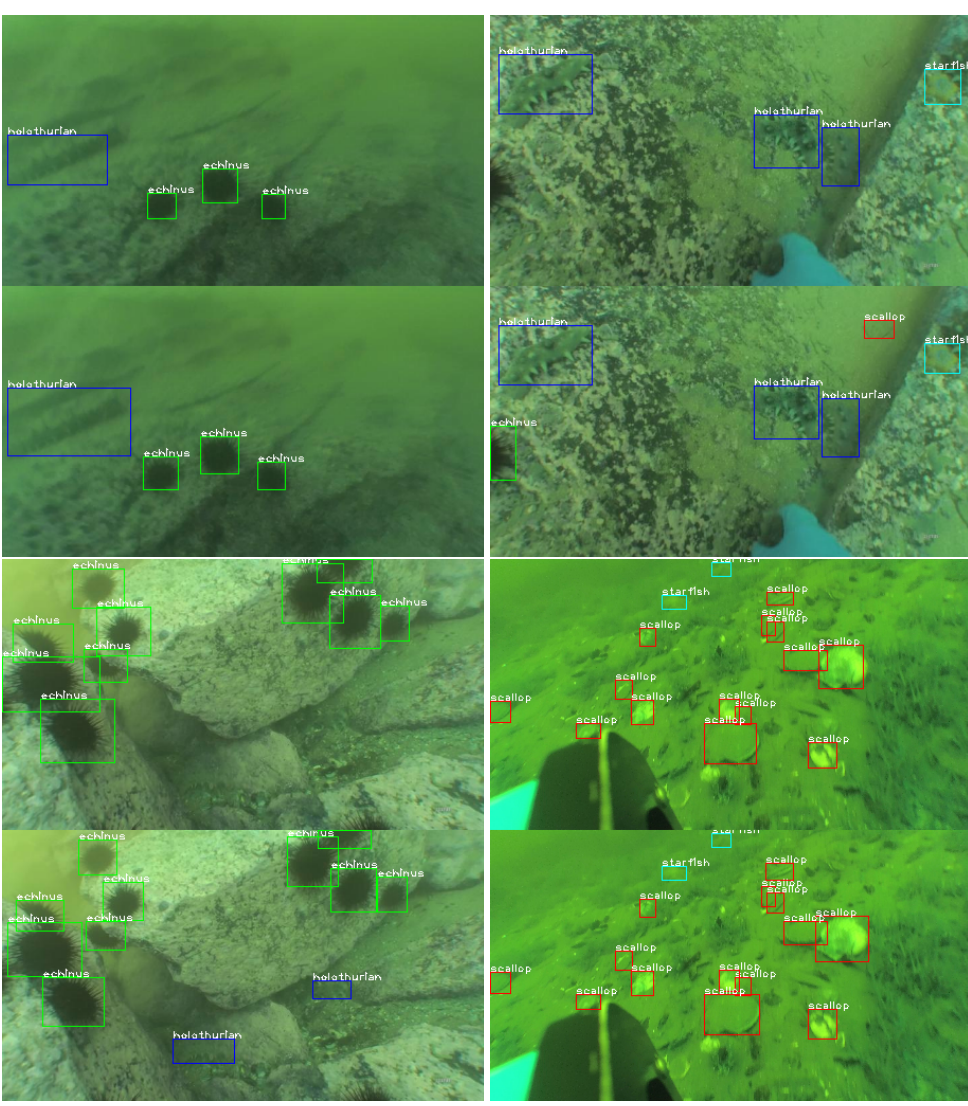
Figure 1. Examplesof the underwater images in the URPC2019 dataset. We show the original annotations (above) and the optimized annotations (below) corresponding to each image. The refined bounding boxes contain fewer annotations errors of missing, mislabeling, and inaccurate positioning caused by blurred images. Better viewed in zoom and